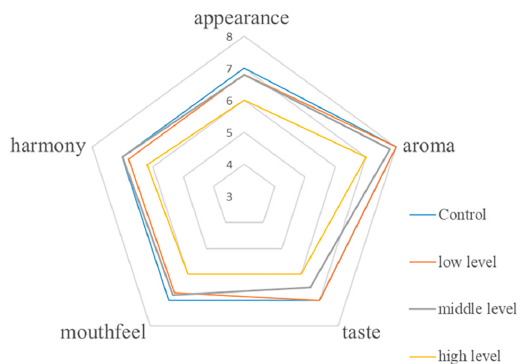
Figure 4. Average radar map of the Chinese rice wine including different level of biogenic amine- Figure4. AverageradarmapoftheChinesericewineincludingdi ff erentlevelofbiogenicamine-reduced reduced Lactobacillus plantarum based on sensory scores. Lactobacillus plantarum based on sensory scores.